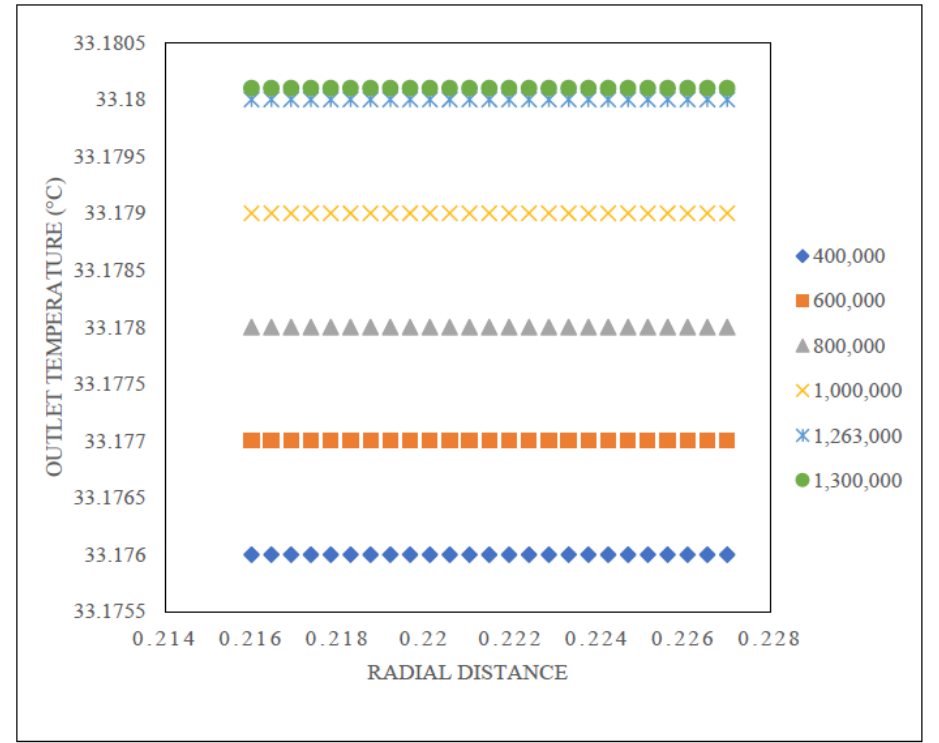
Figure 5. Outlet temperature for various number of elements ranging from 400,000 to 1,300,000.